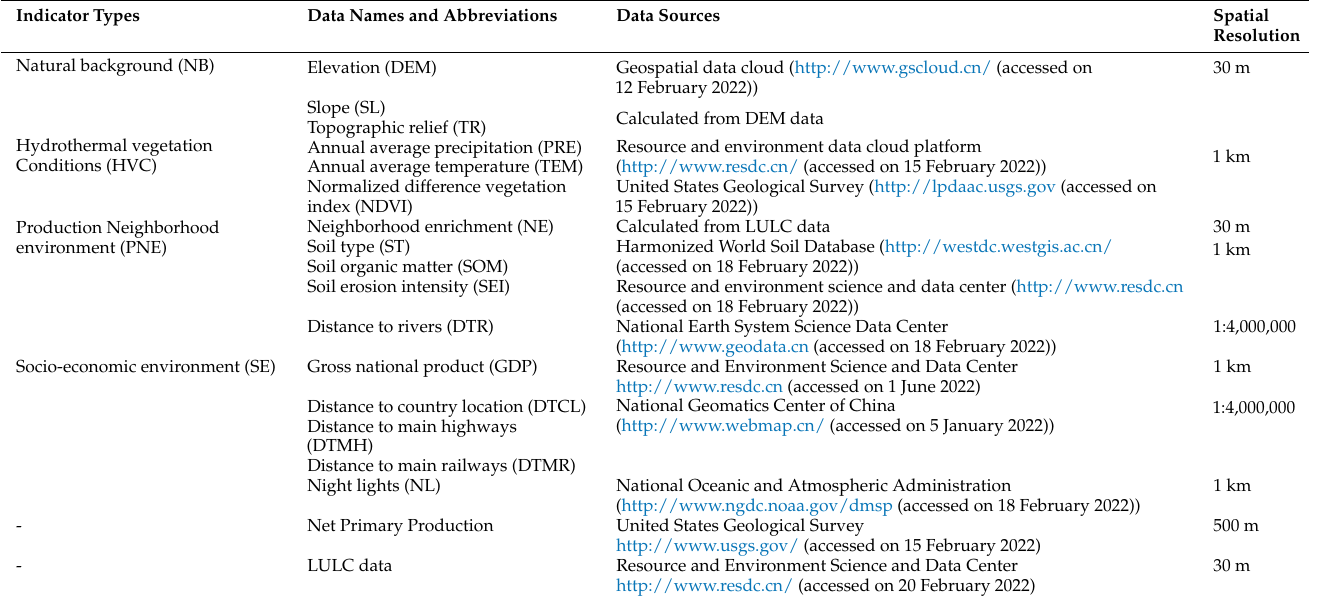
Table 1. Data sources and